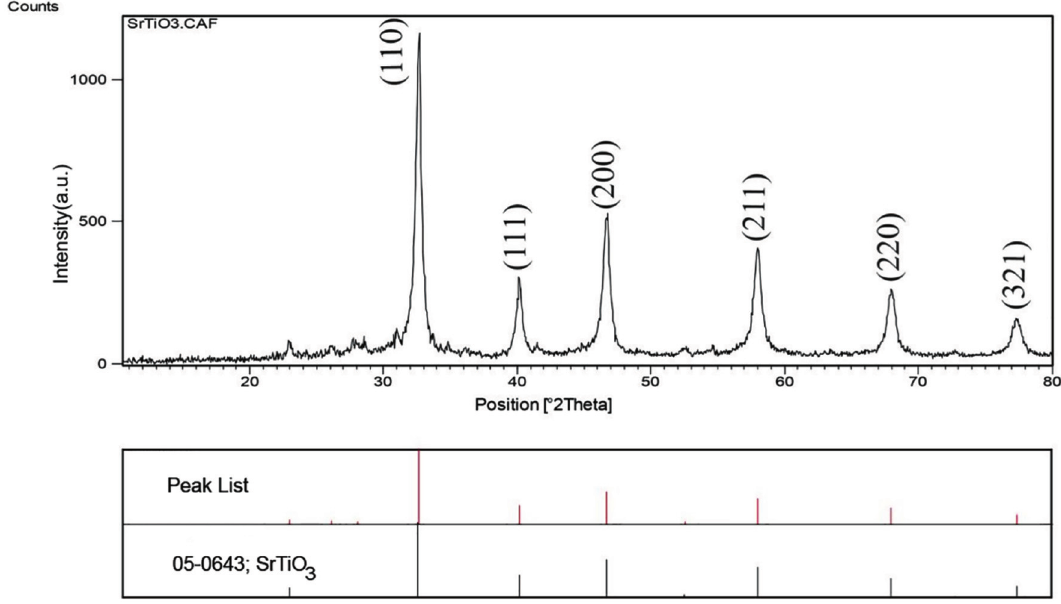
Figure 3: XRD spectrum of SrTiO